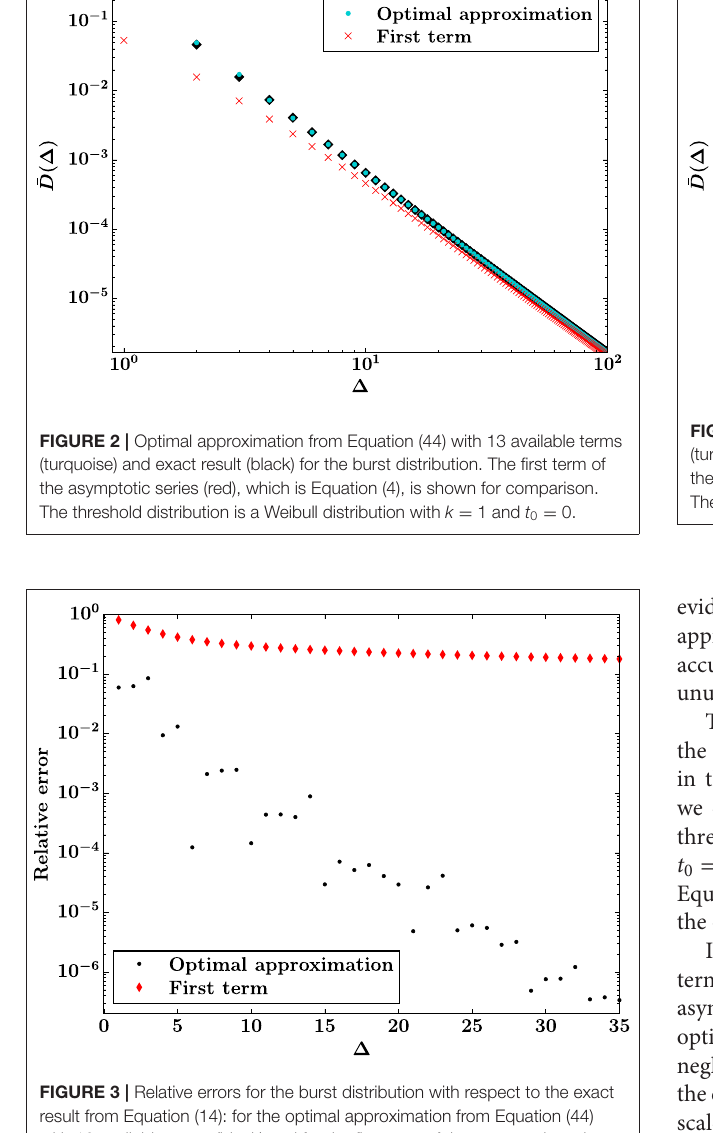
FIGURE 3 | Relative errors for the burst distribution with respect to the exact result from Equation (14): for the optimal approximation from Equation (44) with 13 available terms (black) and for the first term of the asymptotic series (red), which is Equation (4). The threshold distribution is a Weibull distribution with k 1 and t 0 0. = =